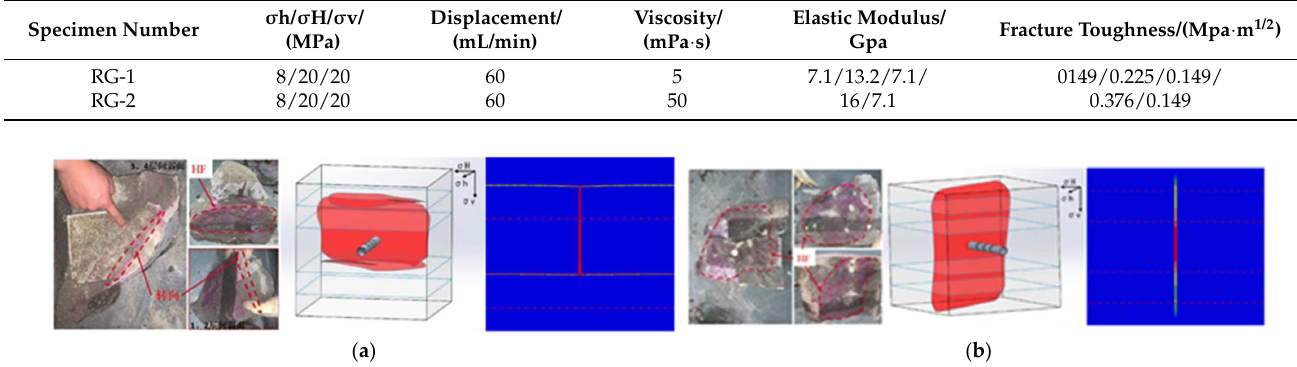
Figure 4. The results of physical simulation experiments and numerical simulation: ( a ) Anatomical map and fracture reconstruction map and numerical simulation results of RG-1 rock sample after the experiment; ( b ) Anatomical map and fracture reconstruction map and numerical simulation results of RG-2 rock sample after the experiment.